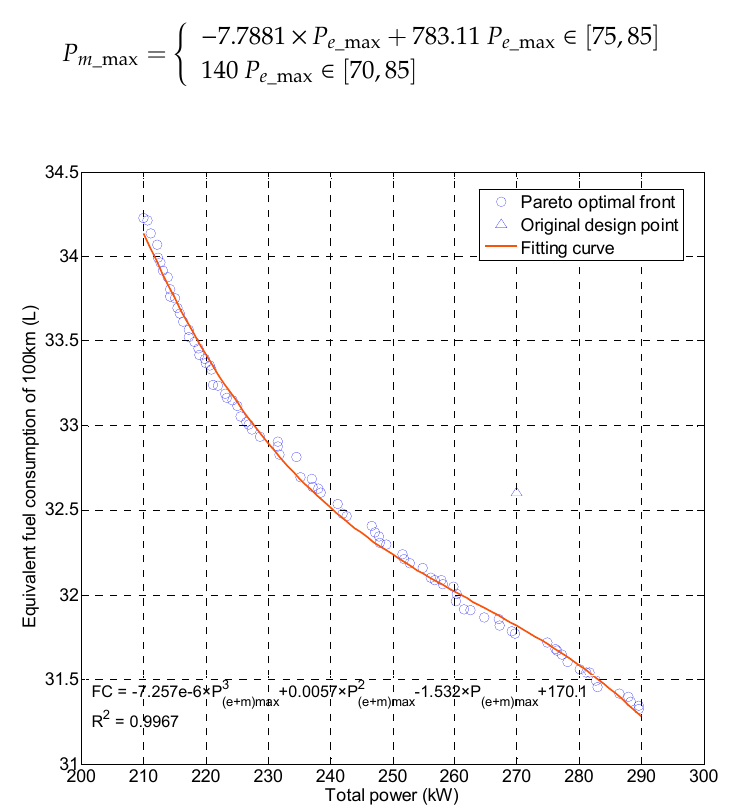
Figure 10. Multi-objective optimization results considering lightweight and fuel economy.